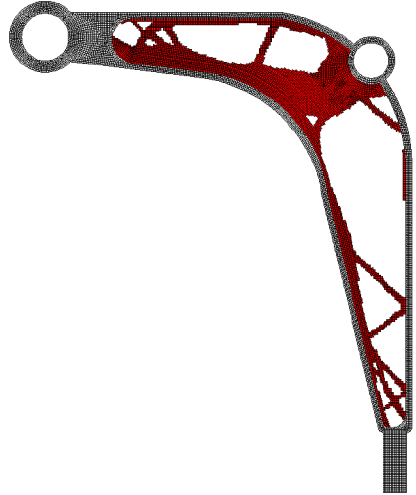
Figure 23. The final topology found for the control arm.